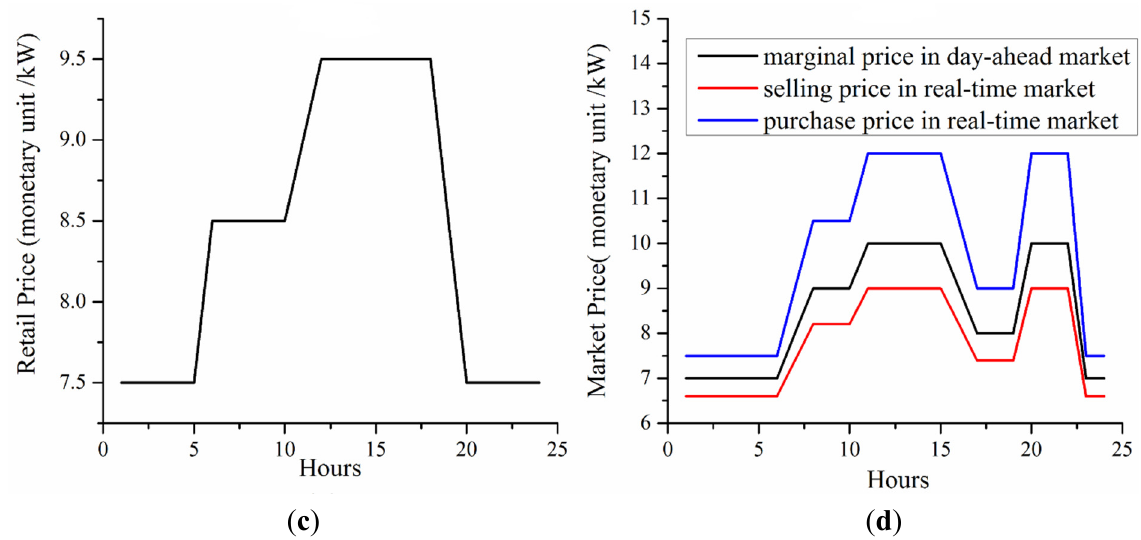
Figure 4. ( a ) Forecasted load; ( b ) The EV battery demand; ( c ) The retail price; ( d ) The marginal price in the day-ahead market as well as the selling price and purchase price in the real-time